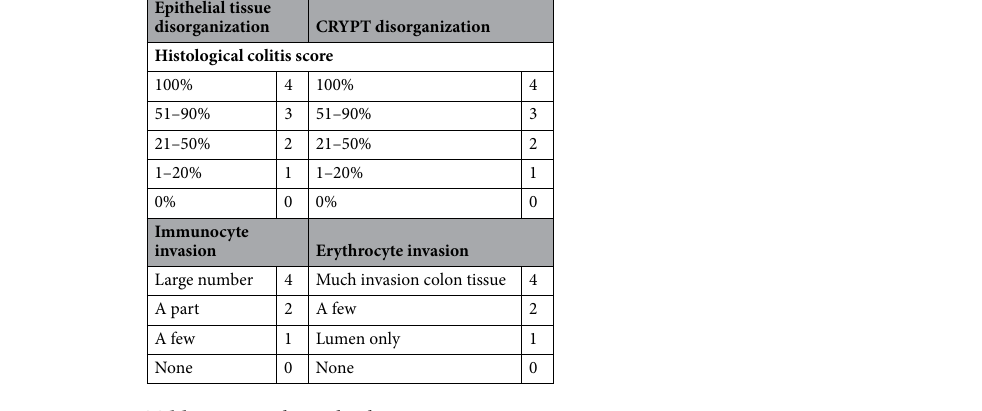
Table 2. Histological colitis